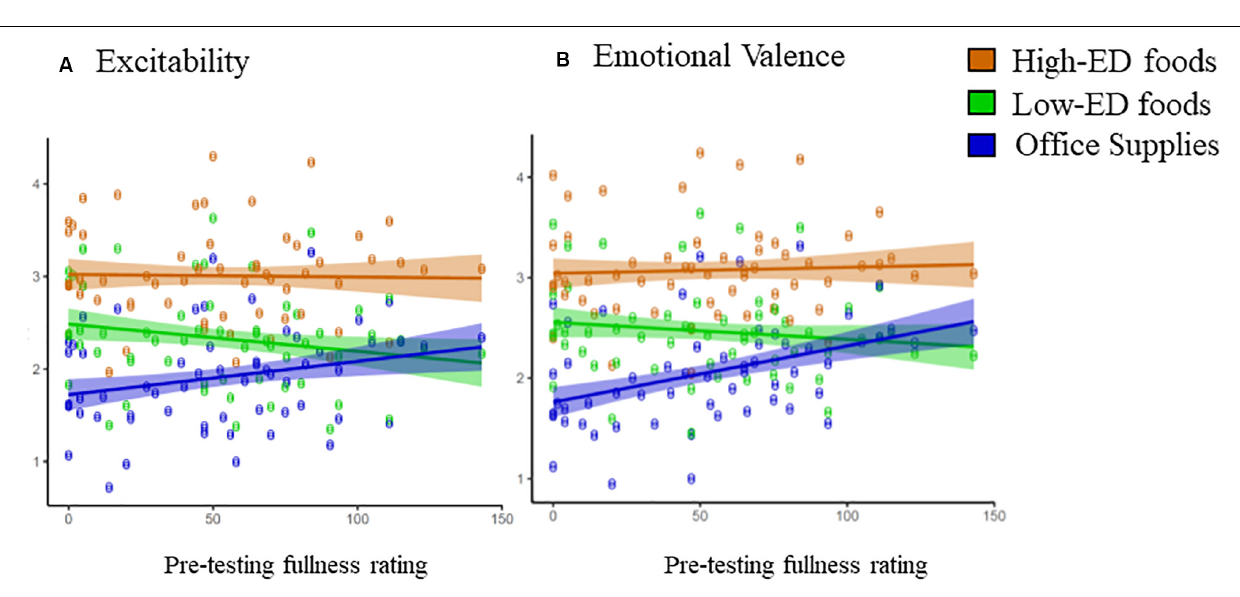
FIGURE 5 | The effect of an interaction between category of image (e.g., high-ED, low-ED, and office images) and fullness score on ratings of image excitability and emotional valence-A. The slopes between excitability and fullness differed by the category of item pictured [ p = 0.002; F (290) = 634]. The slope for office supplies was greater than the slope for high-ED and low-ED foods; however, the slope for low-ED foods did not differ from the slope for high-ED food& Ratings of excitability of low-ED foods and office supplies were significantly different at lower levels of fullness, but were not significantly different at higher levels of fullness- B. The slopes between emotional valence and fullness differed by the category of item pictured [ p = 0M004; F (2294) = 7.92]. The slope for office supplies was greater than the slope for high-ED foods and office supplies, however, the slope for low-ED foods did not differ from the slope for high-ED foods. Ratings of emotional valence of low-ED foods and office supplies were significantly different at lower levels of fullness, but were not significantly different at higher levels of